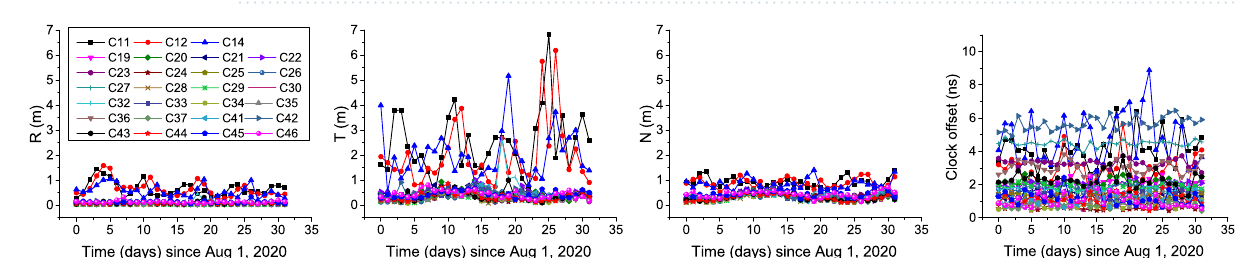
Figure 3. Orbit and clock offset accuracy variations of the IGSO satellites. From left to right: Radial, tangential, normal, satellite clock offset.